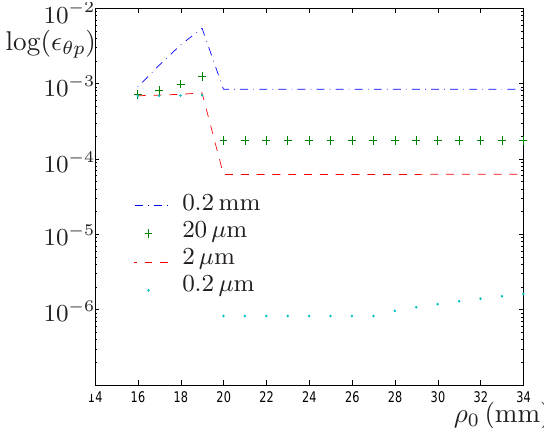
Figure 6. Discrepancy in θ p between KSM and QSM for di ff erent ∆ ρ 0